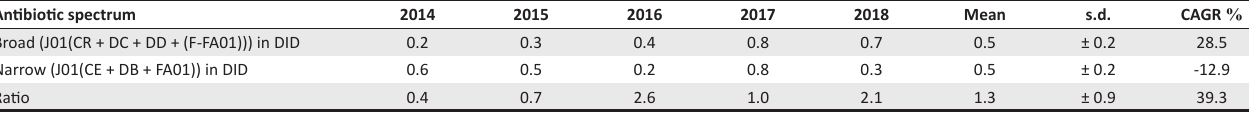
TABLE 3: Broad- and narrow-spectrum antibiotic consumption. Antibiotic spectrum